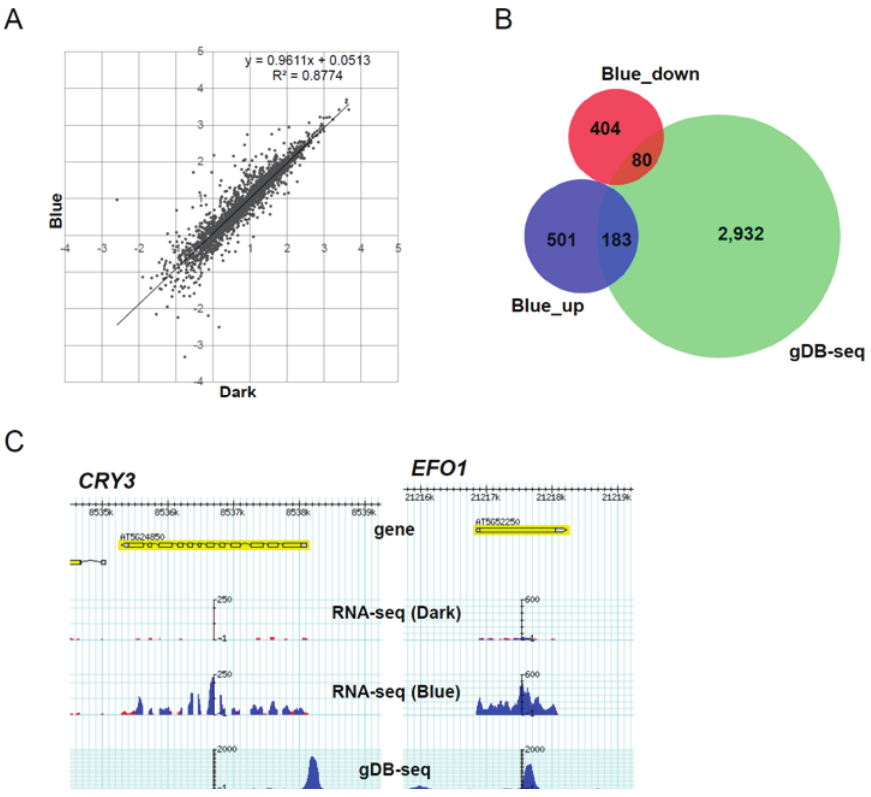
Figure 8. Relationship between HY-5 binding potential and early blue-light response. ( A ) Dot plot of the accumulation of 2631 HY5-binding genes in plants grown in the dark and under blue light for 1 hour. LOG10 (in (cid:2)4~4) values of FPKMs (Fragments per kilobase of exon per million mapped reads) were plotted. ( B ) Venn diagram of the overlaps between HY5-binding genes (gDB-seq), blue-inducible genes (Blue_up) and blue-repressed genes (Blue_down). ( C ) Genome browser view of two examples (the CRY3 and EFO1 loci) of blue light-inducible genes with HY5-binding sites. ( D ) Semi-quantitative RT-PCR (Reverse Transcription-Polymerase Chain Reaction) analysis of nine HY5-binding genes, HY5 and ACT2 . ACT2 accumulation was used as a loading control. The peak positions of gDB-seq are shown on the